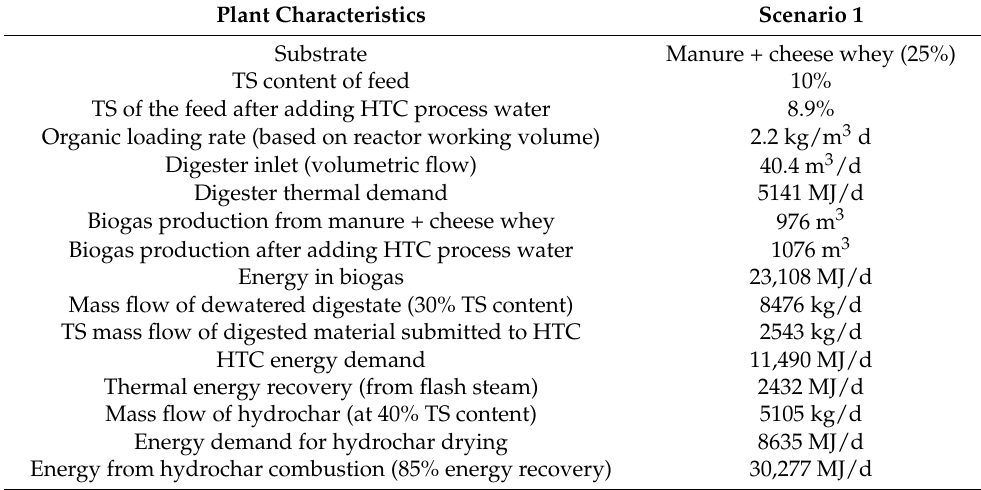
Table 3. Main calculated parameters of the integrated system: anaerobic digestion and HTC Scenario 2. Manure and cheese whey (25% v / w ) used as